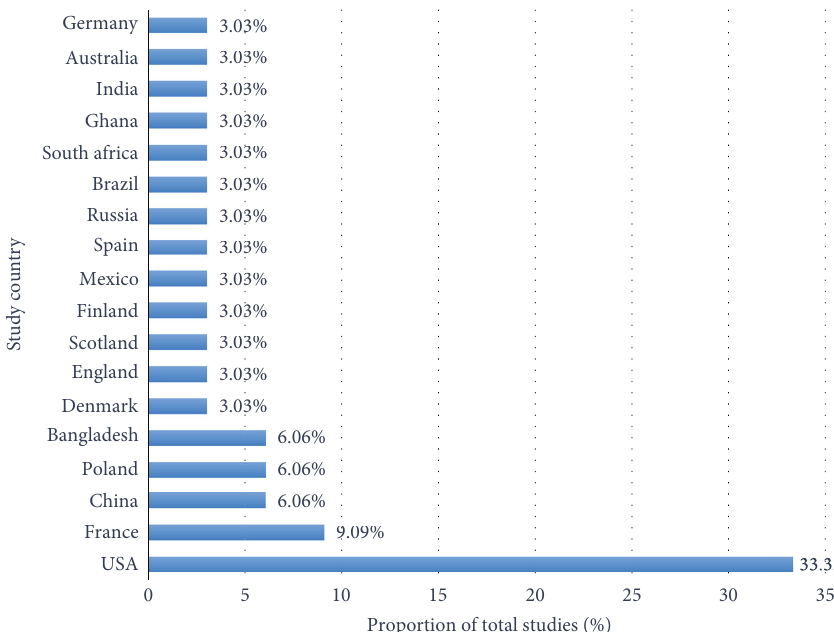
Figure 3: Trend of studies on risk factors for suicide by study country. About one-third of the studies (33.33%) were conducted in the USA.